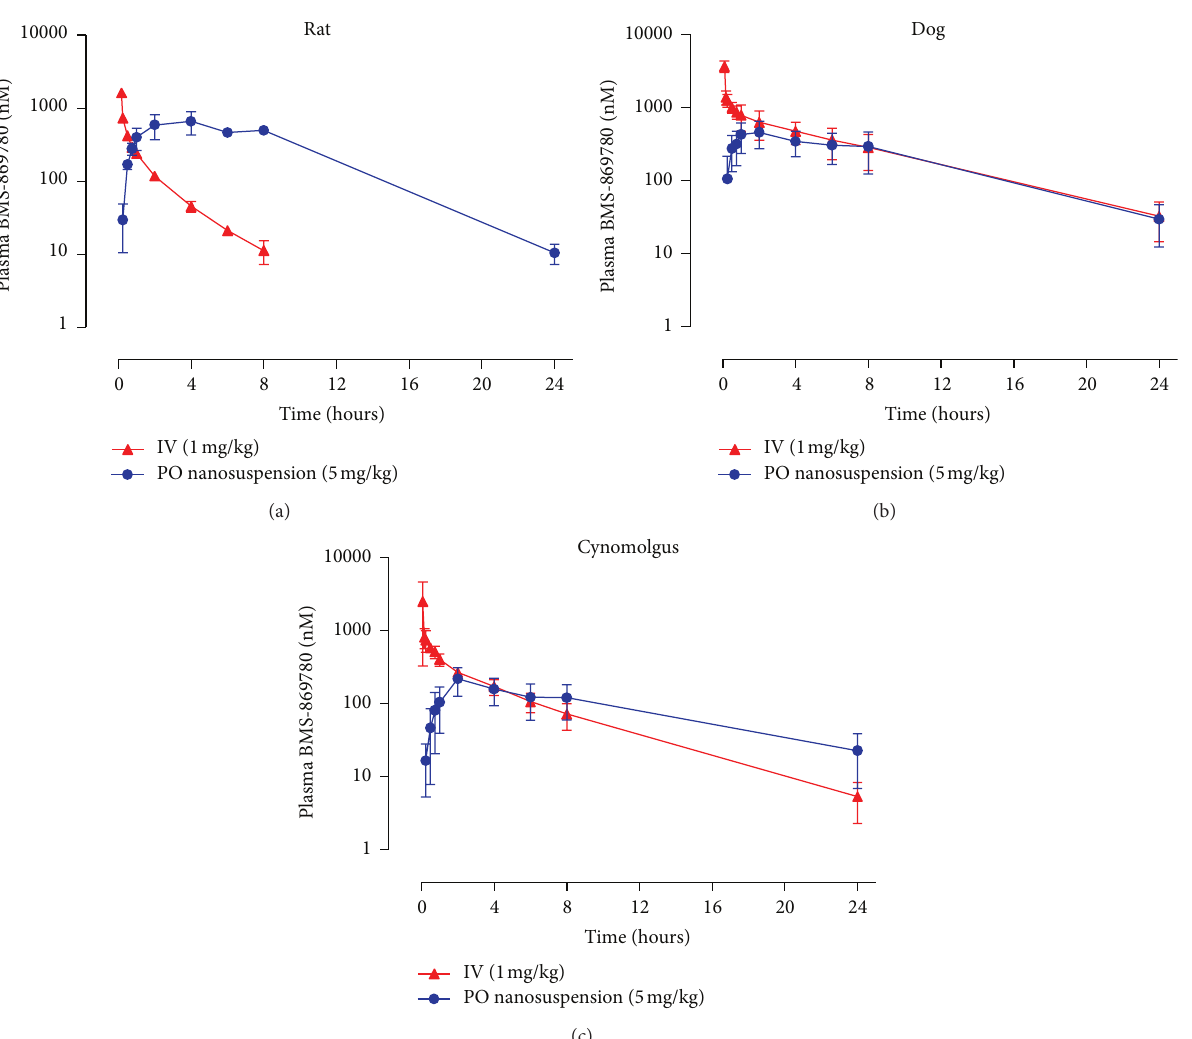
Figure 9: Pharmacokinetics (PK) of BMS-869780 across species for prediction of human PK. Rats, dogs, and cynomolgus monkeys were dosed with BMS-869780 intravenously (IV 󳵳 ) at 1mg/kg or oral nanosuspension (PO e ) at 5mg/kg. Plasma concentrations of BMS-869780 were determined for up to 24 hours after the dose. (a) Rat. (b) Dog. (c) Cynomolgus monkey. The derived PK parameters are summarized